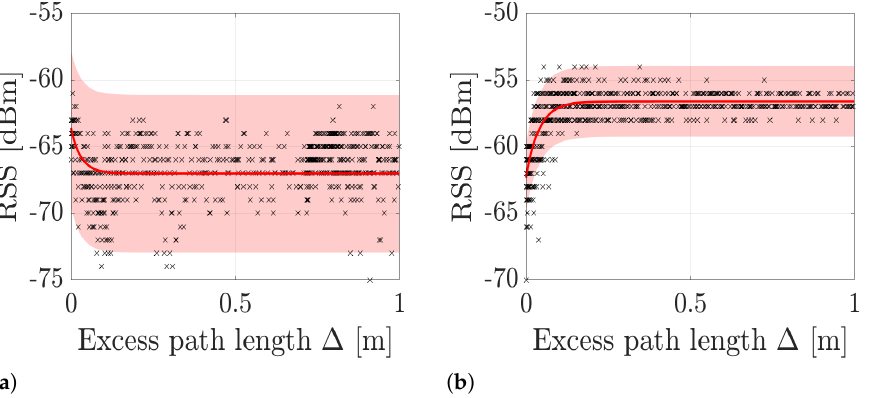
Figure 2. Measured ( ) and modeled ( ) RSS as a function of excess path length for two example links. The shaded region depicts the 3 σ confidence interval. In ( a ), the model parameters are Θ = [ − 67.02,3.42,0.03,3.92 ] and in ( b ), Θ = [ − 56.61, − 5.71,0.04,0.80 ]